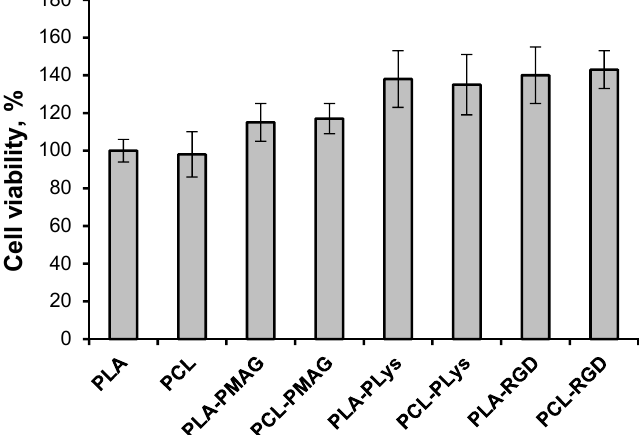
Figure 9. MTT-test results: cell incubation on initial PCL and PLA matrices and on those modified with ox-PMAG followed by poly- L -lysine (PLL) and RGD-peptide binding.